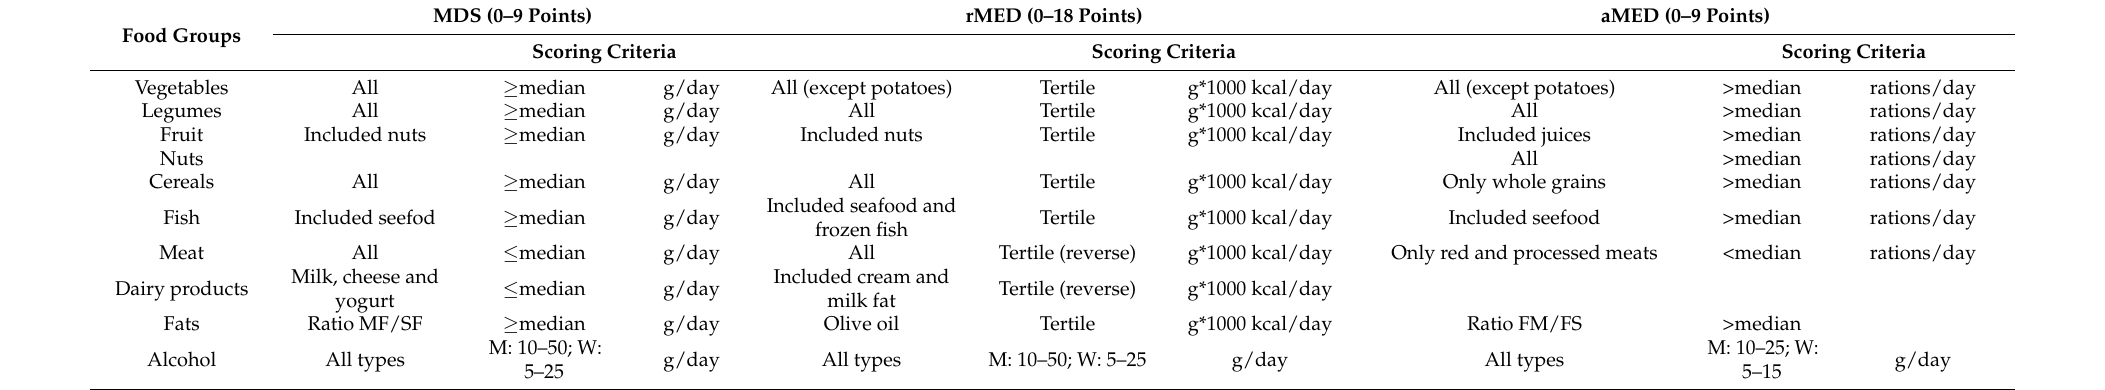
Table 2. Characteristics of the different adherence indexes to the Mediterranean diet.